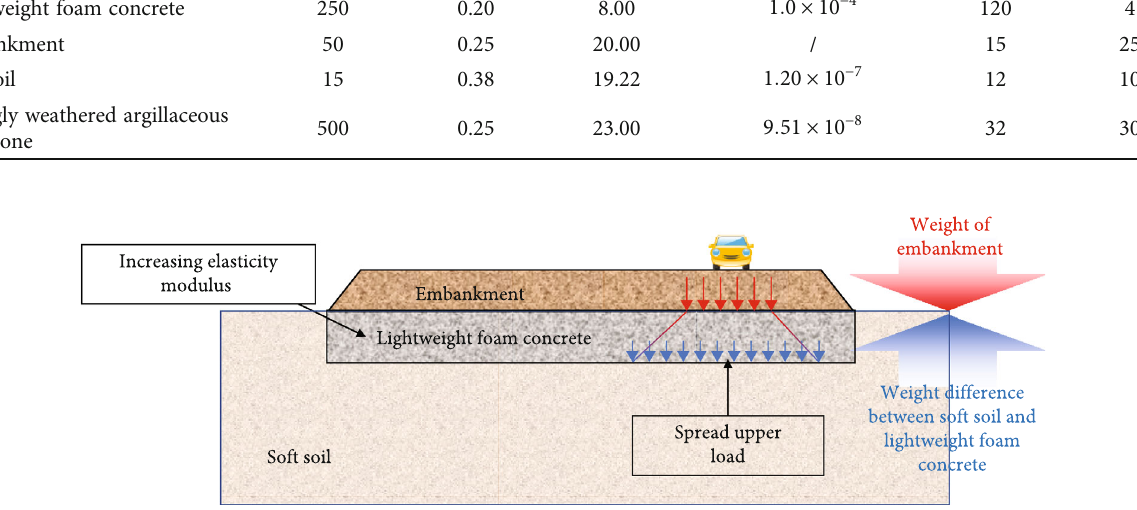
Figure 2: Scheme of the lightweight foam concrete replacement